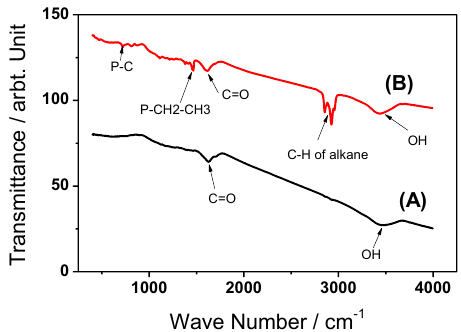
Figure 2. ( A ) FTIR spectra of Activated Carbon from mixed recyclable waste (ACMRW) and ( B ) the